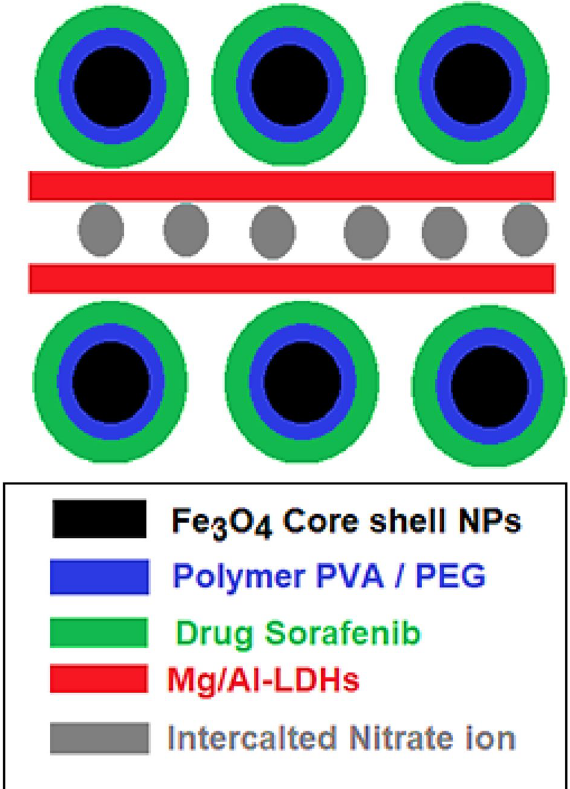
Figure 1. Schematic illustration of the designed core–shell